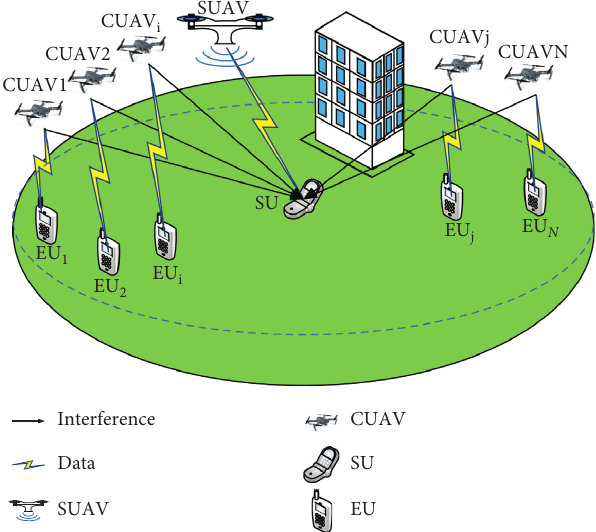
Figure 1: Downlink power control system model of